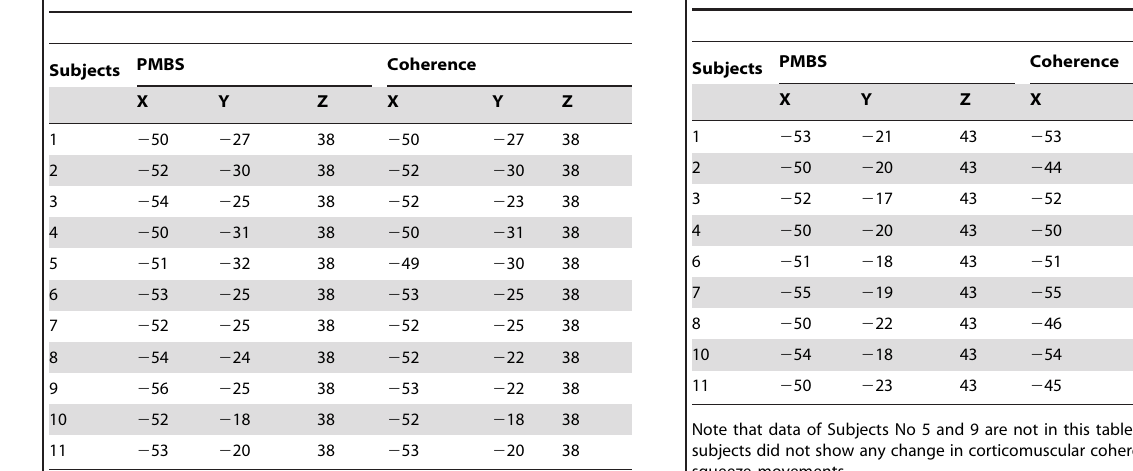
Table 3. MNI co-ordinates of the first source voxel with the maximum PMBS and maximum coherence in Task 1.